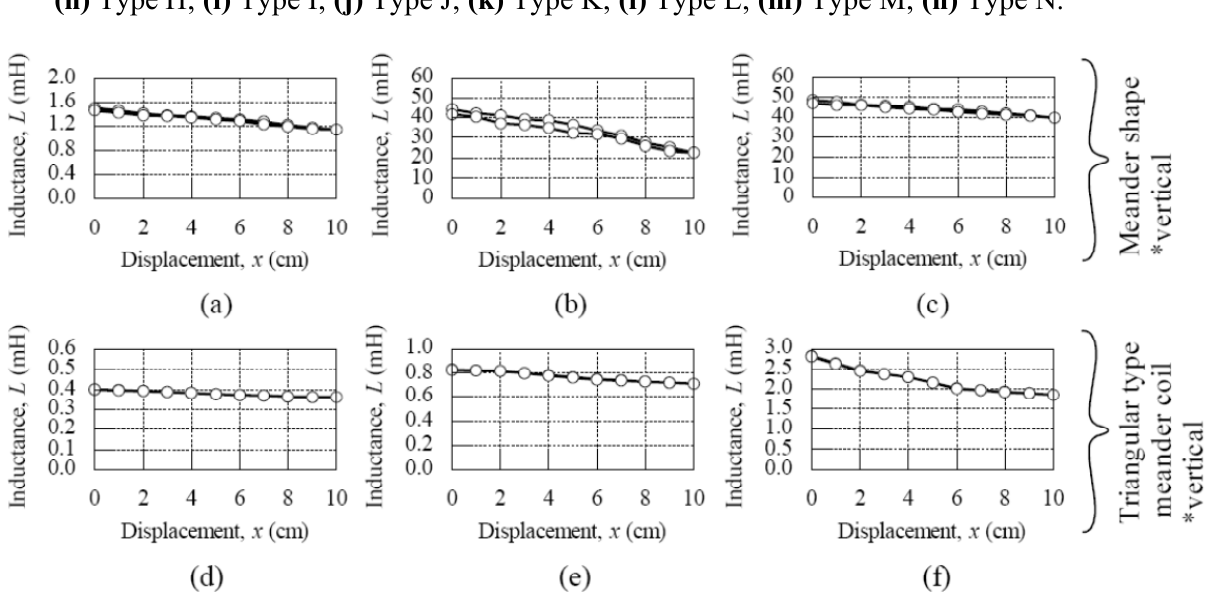
Figure 7. Inductance characteristic for various shapes of inductive coil ( f = 5 kHz, V